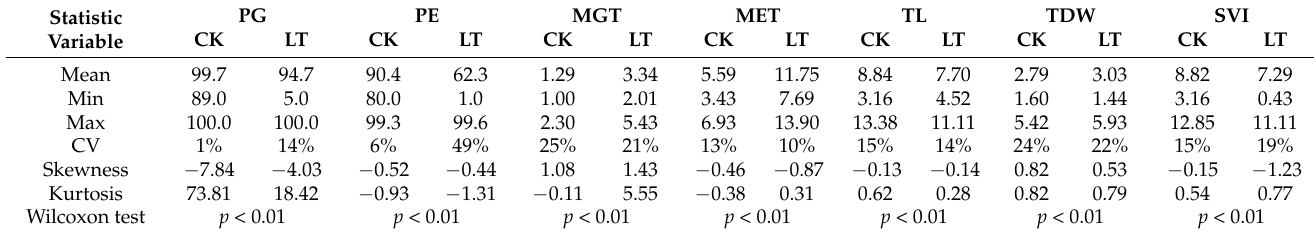
Table 1. Statistic variables of seed germination- and seedling emergence-related indices under normal- and low-temperature conditions. PG, percentage of germination (%); PE, percentage of emergence (%); MGT, mean germination time (d); MET, mean emergence time (d); TDW, total dry weight (mg/plant); TL, total seedling length (cm/plant); SVI, seedling vigor index; CV, coefficient of variation. The significance of the differences between normal- and low-temperature conditions was determined by the Wilcoxon signed-rank test.